Question: Author a descriptive caption for the visualization shown.
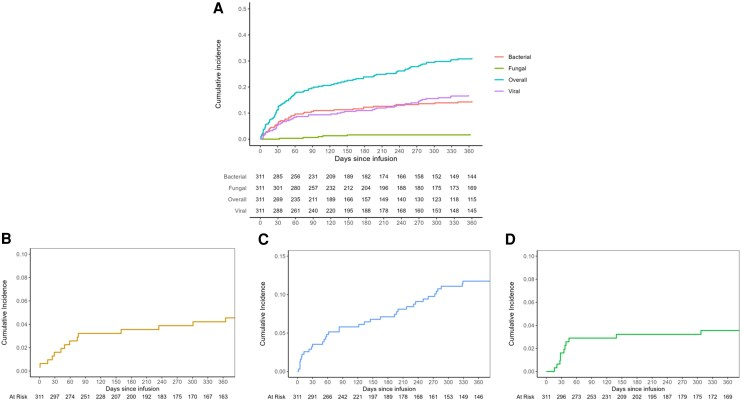
Answer: Cumulative incidence curves for postchimeric antigen receptor T-cell therapy (CART) infection by pathogen type ( A ), post-CART bloodstream infection ( B ), post-CART respiratory viral infection ( C ), post-CART cytomegalovirus infection ( D ).